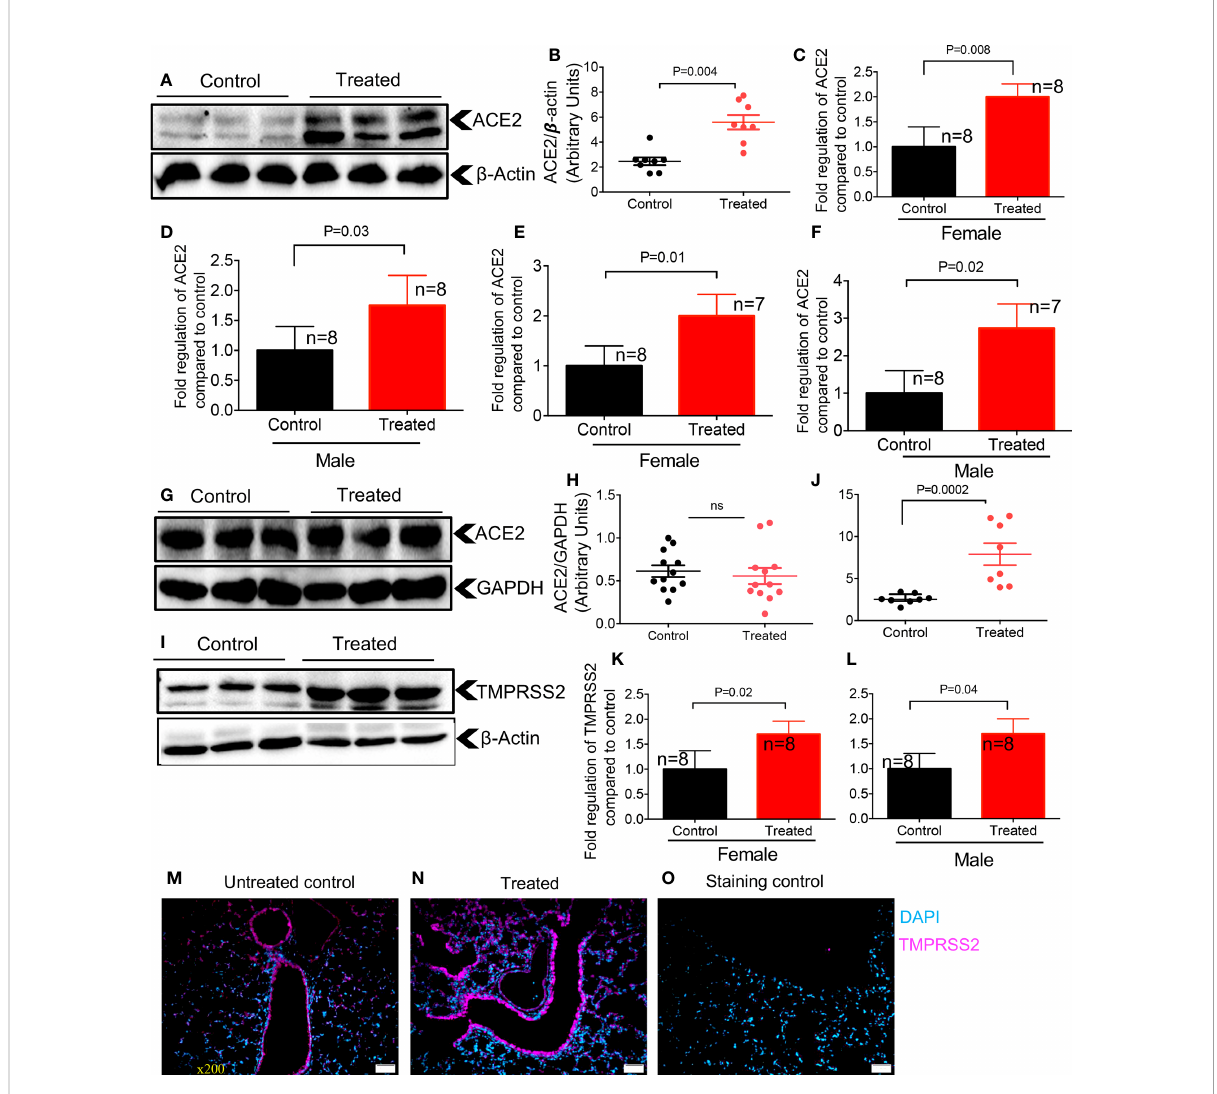
FIGURE 5 Dexamethasone upregulates the expression of ACE2 and TMPRSS2 in the lung and heart tissues of adult mice. (A) Representative western immunoblots, and (B) cumulative data of ACE2 protein in the lung tissues of adult mice (> 6 months) treated with dexamethasone (IP, 1 m g/g body weight for two consecutive days) versus those treated with PBS (control). (C) Cumulative data showing fold regulation of ACE2 mRNA in the lung tissues of treated male, and (D) female versus control mice. (E) Cumulative data showing fold regulation of ACE2 mRNA in the heart tissues of treated male, and (F) female versus control mice. (G) Representative western immunoblots, and (H) cumulative data of ACE2 protein in the heart tissues of adult mice (> 6 months) treated with dexamethasone versus controls. (I) Representative western immunoblots, and (J) cumulative data of TMPRSS2 protein in the lung tissues of adult mice (> 6 months) treated with dexamethasone versus controls. (K) Cumulative data showing fold regulation of YMPRSS2 mRNA in the lung tissues of treated male, and (L) female versus controls. (M) IF images of TMPRSS2 expression in the lung tissue of a control versus (N) dexamethasone treated adult mouse. (O) Stained with the secondary antibody (5 sections/tissue, n= >3/group). Scale bar: 100 m m. Magni fi cation x200. All blots were repeated for reproducibility and lanes were loaded with equal amounts of protein. Quanti fi cation of ACE2 and TMPRSS2 normalised to the loading control. Error bars indicate mean ± SEM from more than three independent experiments. ns, Not signi fi